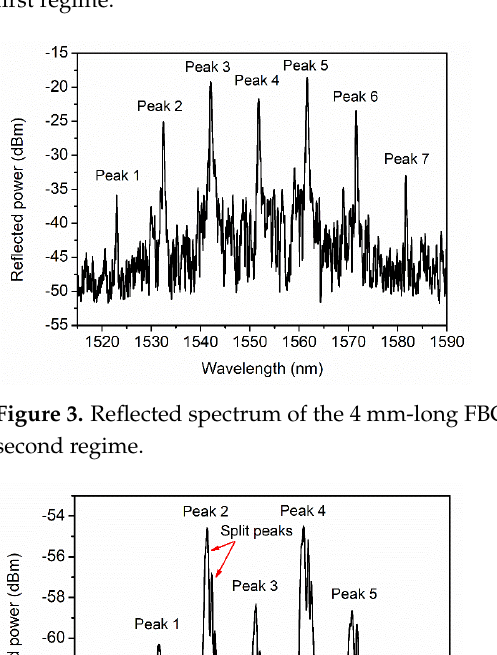
Figure 2. Reflected spectrum of the 2 mm-long FBG inscribed with a pulse energy of 11.22 nJ in the first regime.